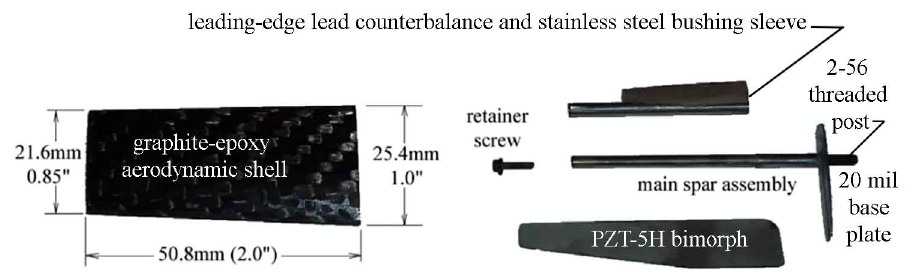
Figure 11. Major Components of Flexspar Actuator and Aeroshell.